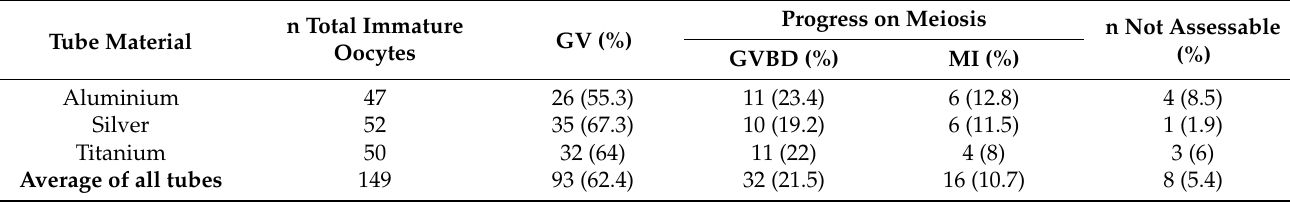
Table 2. Results of fluorescence analysis of immature oocytes after warming and IVM. Oocytes are classified as those that remained in the GV stage or those that went on with the resumption of meiosis (GVBD or MI). n Total Immature Tube Material